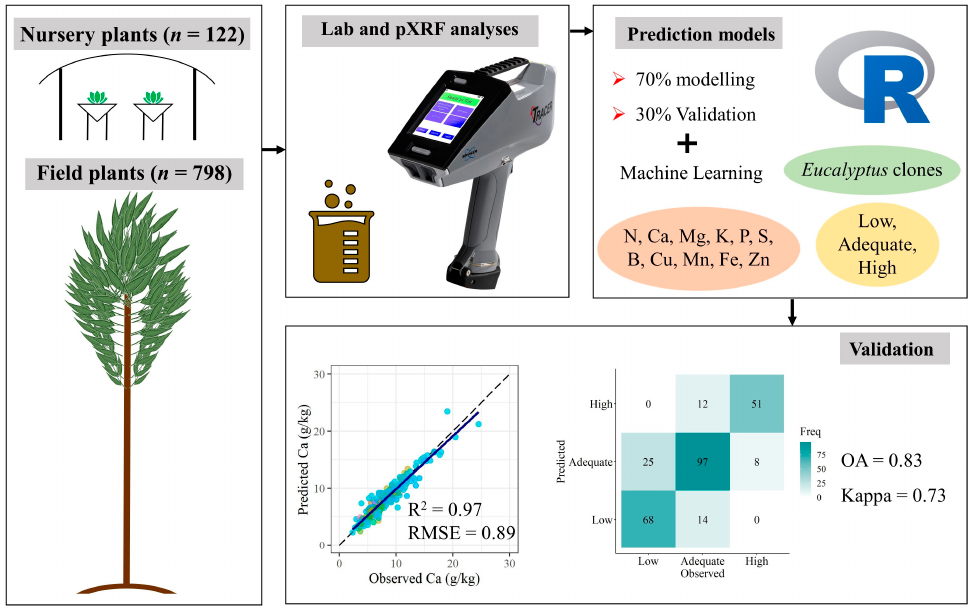
Figure 7. Flowchart illustrating the sequence of the methodological process of this work for predicting the nutrient status of Eucalyptus spp. leaves and Eucalyptus spp. clones.